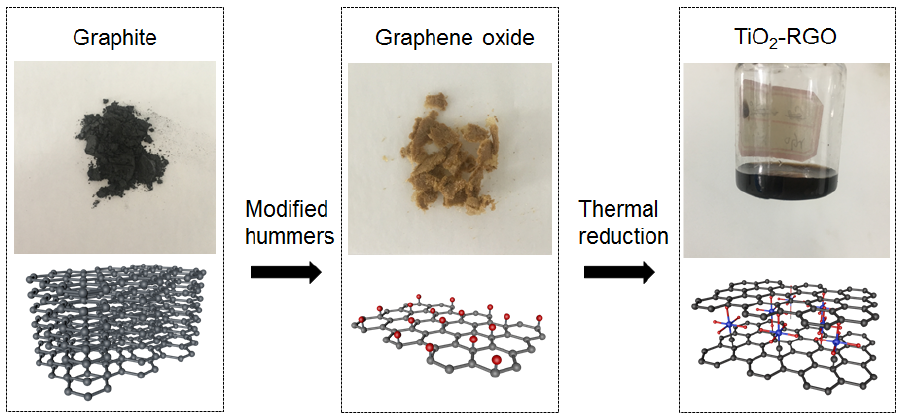
2 -RGO nanocomposites.